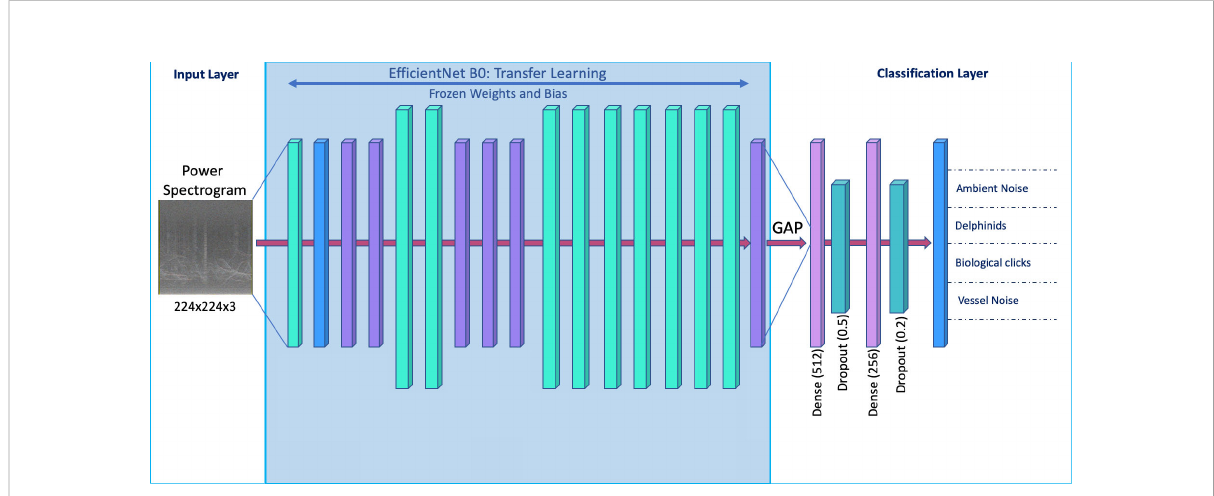
FIGURE 6 Schematic diagram of the CNN model. Transfer learning was used to build the model, freezing weights and biases from the original Ef fi cientNet B0 architecture, represented by the blue shaded region. White regions are fi ne-tuned layers, trained on our dataset. The model learns representations of the input at each stage of the CNN, the learned features are bottlenecked in the Global Average Pooling (GAP) layer, before being fed into the custom layers. Layer composition is described within the main text. Drop out layers were introduced to enhance the model ’ s ability to generalize to unseen data. The fi nal layer has four neurons per sound source category, with the ability to adjust this layer to new categories of